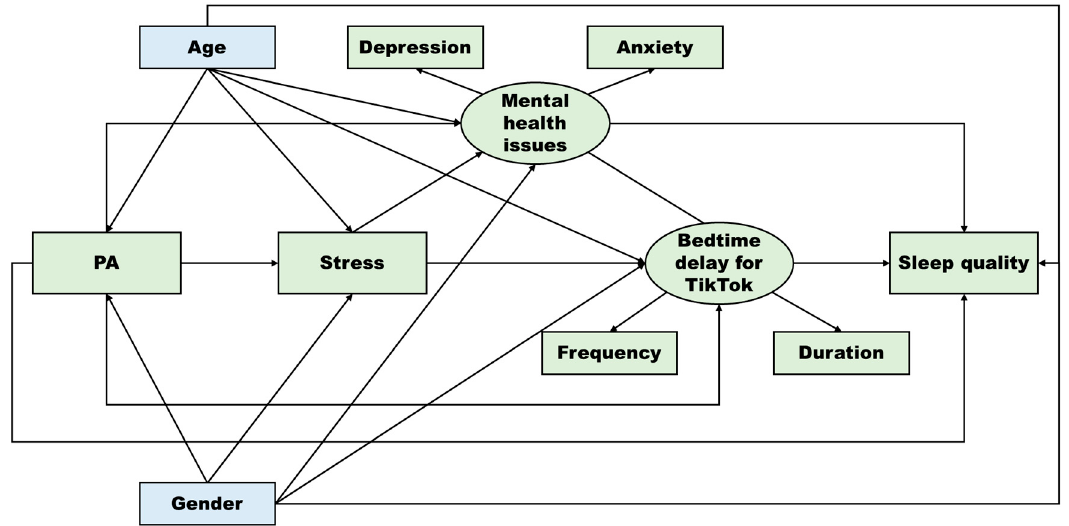
Figure 1. Conceptual model of physical activity–sleep quality pathways for TikTok users.